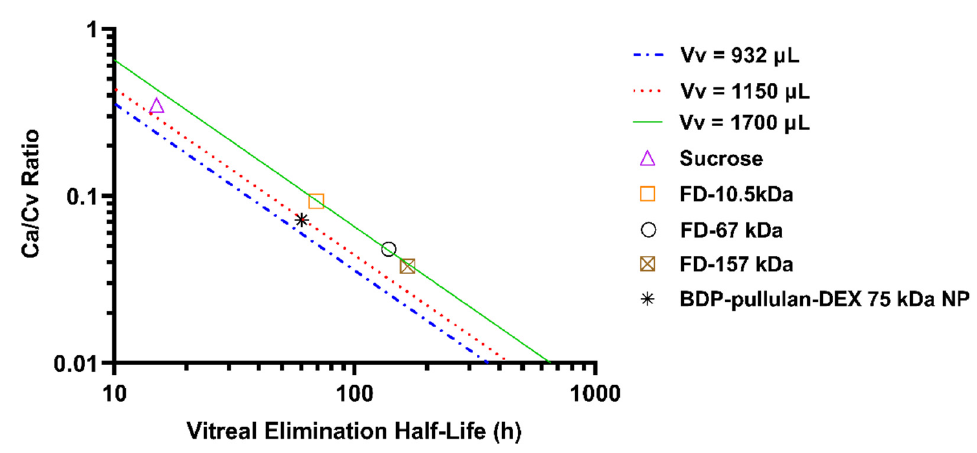
Figure 7. Maurice plot of intravitreally administered compounds in the rabbit eyes. The plot shows anteriorly eliminating compounds based on literature data: sucrose (0.342 kDa) [51], FITC-dextran (FD-10.5, FD-67 and FD-157 kDa) [52,53]. The green, red and blue line are derived from Maurice equation by assuming 932, 1150 and 1700 μ L as vitreal volume of distribution. Location of BDP- pullulan-DEX NP (~75 kDa) data at close vicinity of the straight lines indicates anterior route of elimination in the rabbit eyes as the main elimination pathway.